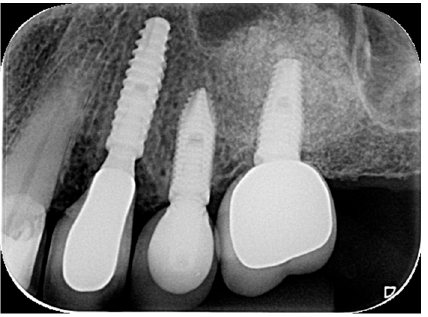
Figure 10. Periapical radiograph of #24 in function for 14 months.